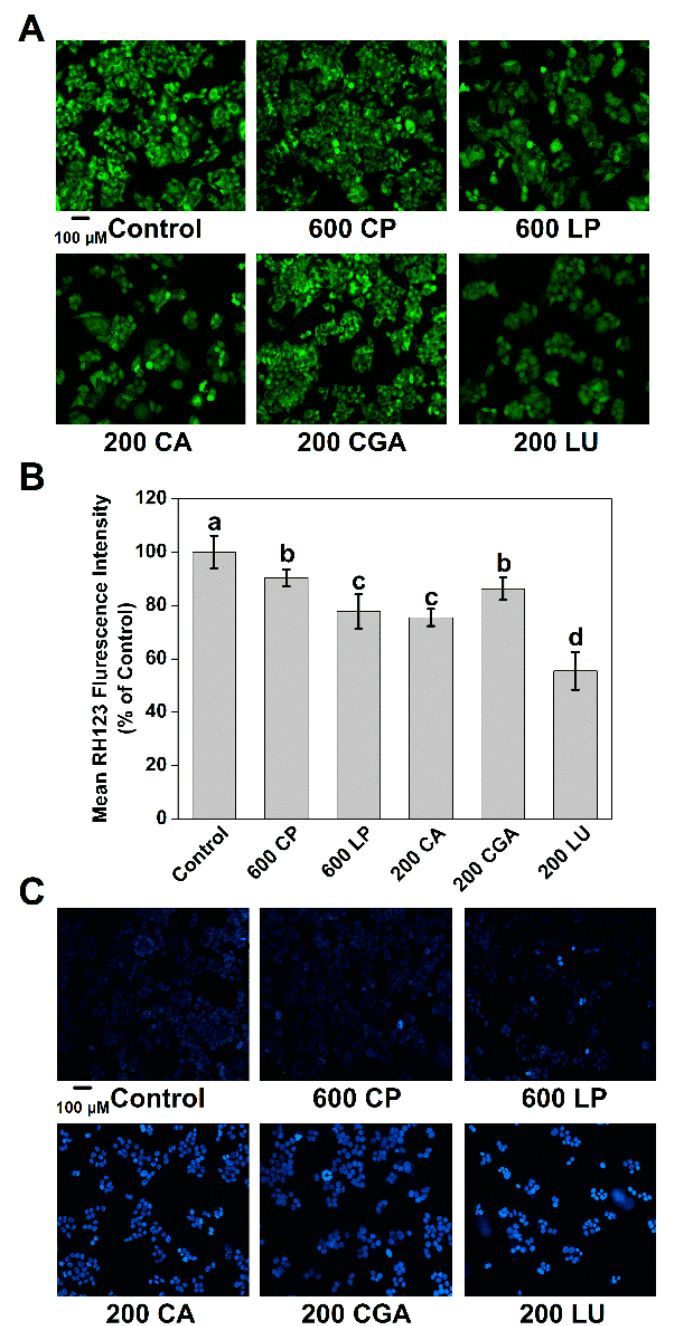
Figure 4. Effects of lettuce extracts and pure individual phenolic compounds on mitochondrial membrane potential and DNA damage in Caco-2 cells. (A) The mitochondrial membrane potential determined by fluorescence microscopy after incubation with RH 123. (B) The quantitative data of mean RH 123 fluorescence intensity. (C) Nuclear staining of Caco-2 cells with Hoechst 33258. Different letters indicate significant difference at P < 0.05.